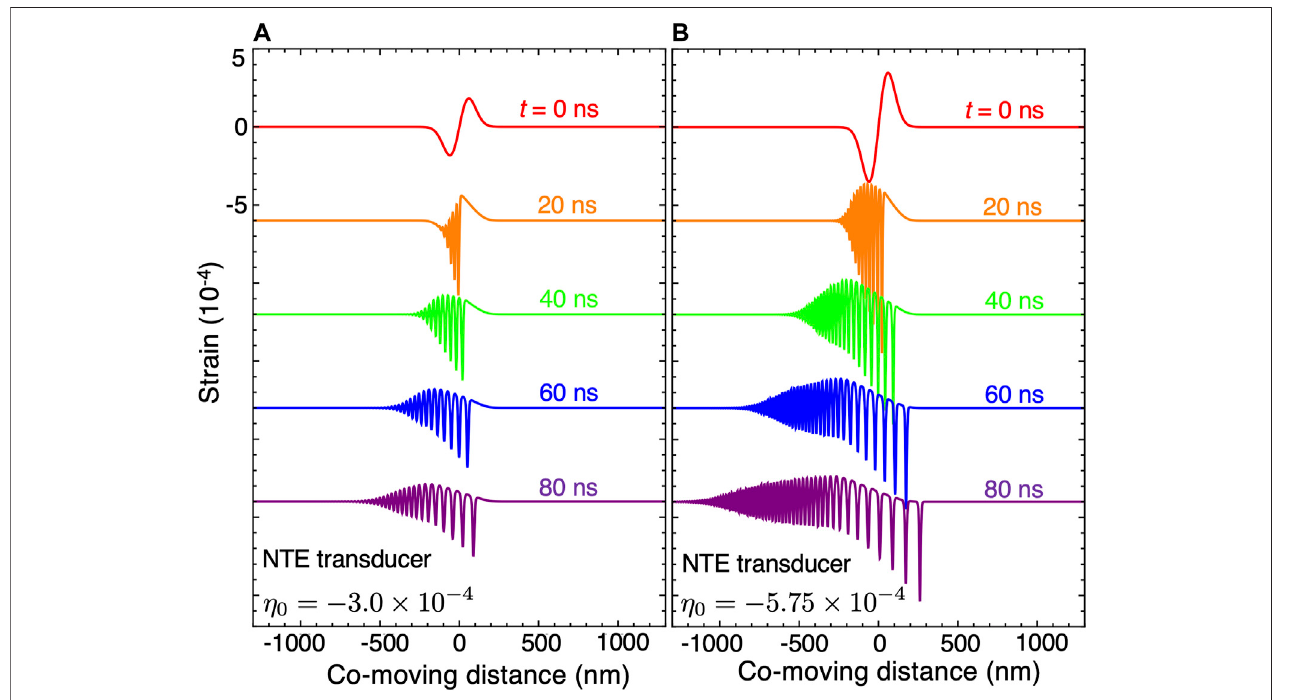
FIGURE 3 | Evolution of strain pulses generated in materials with negative thermal expansion for initial strain amplitudes (A) η 0 (cid:1) − 3.0 × 10 – 4 and (B) η (cid:1) − 5.75 × 10 – 4 0